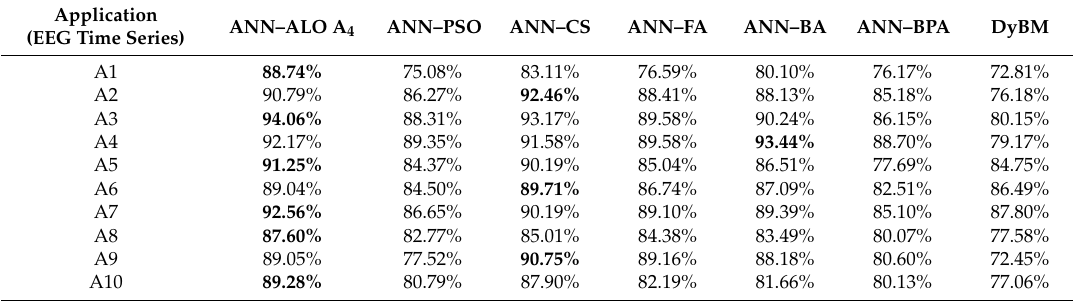
Table 11. Mean accuracy of different approaches for predicting the test data of each EEG time series (set 1).